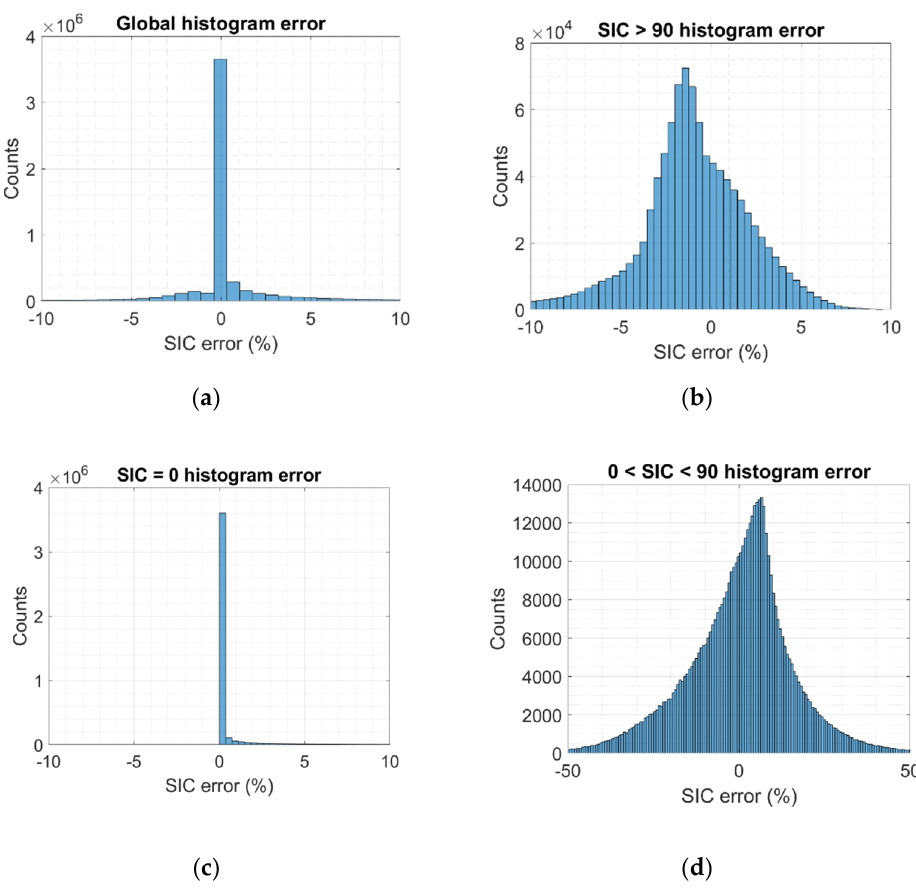
Figure 8. Arctic SIC MWR error histogram: ( a ) Global, ( b ) SIC > 90%, ( c ) SIC = 0 ( d ) 0 < SIC < 90.